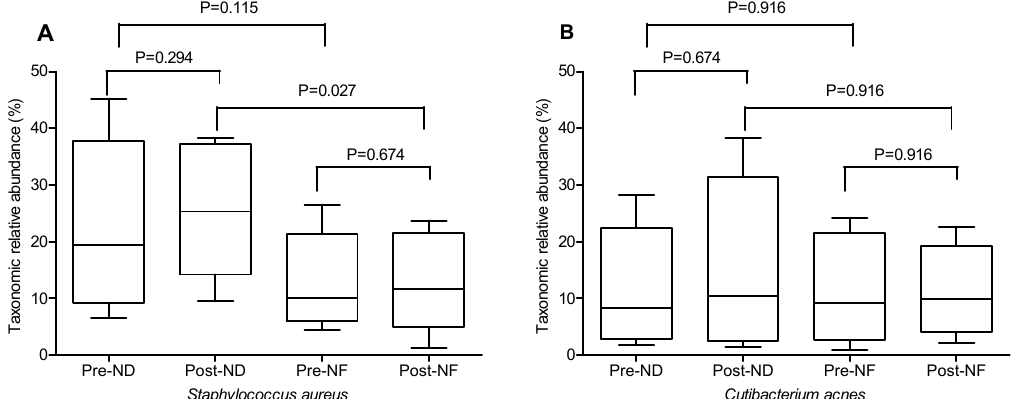
Figure 5. The relative abundances of Staphylococcus aureus ( A ) and Cutibacterium acnes ( B ) in the four groups. ND (control serum); NF (cosmetic serum containing GOS).